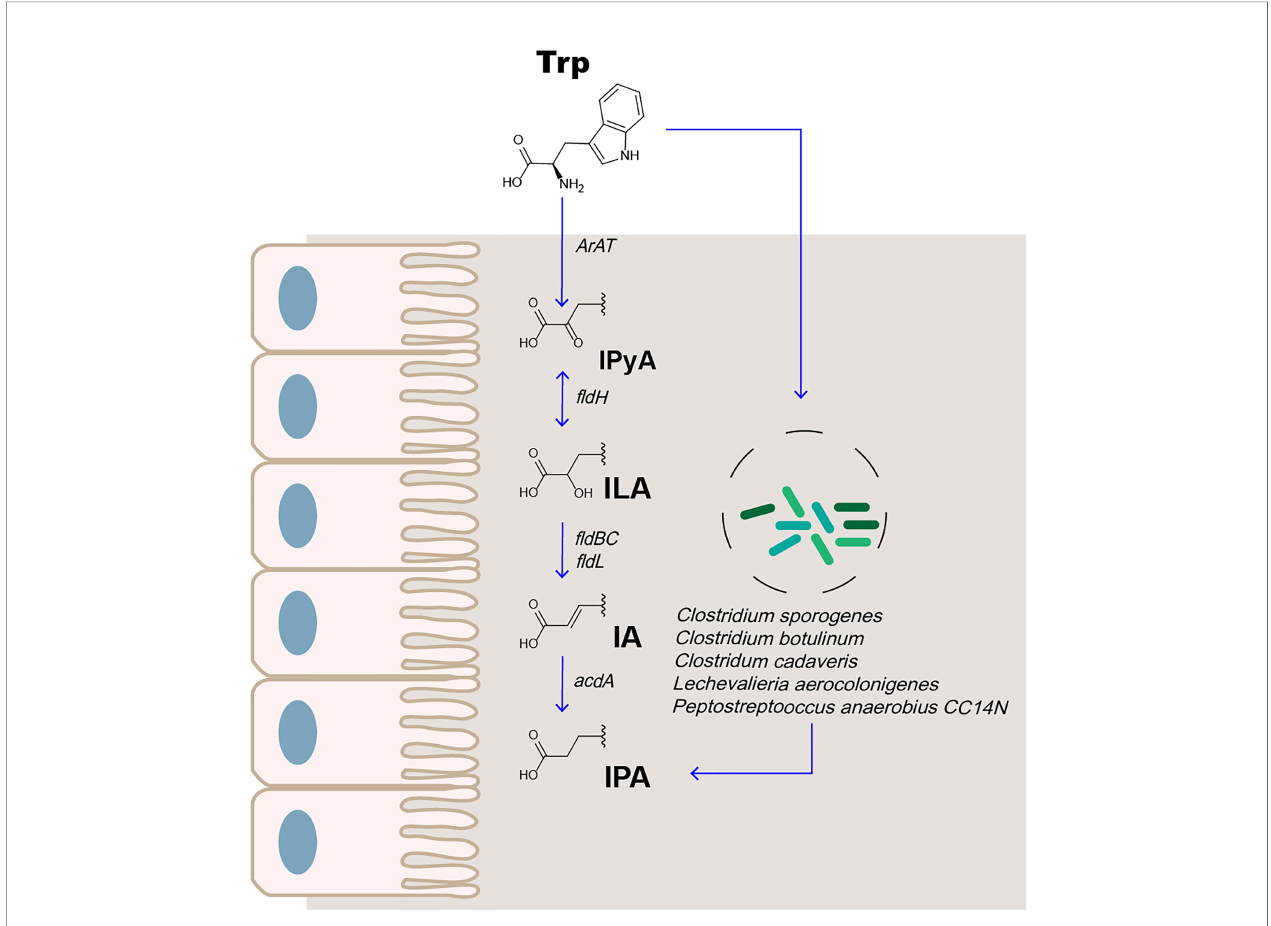
FIGURE 1 | IPA is the metabolite of Trp in the